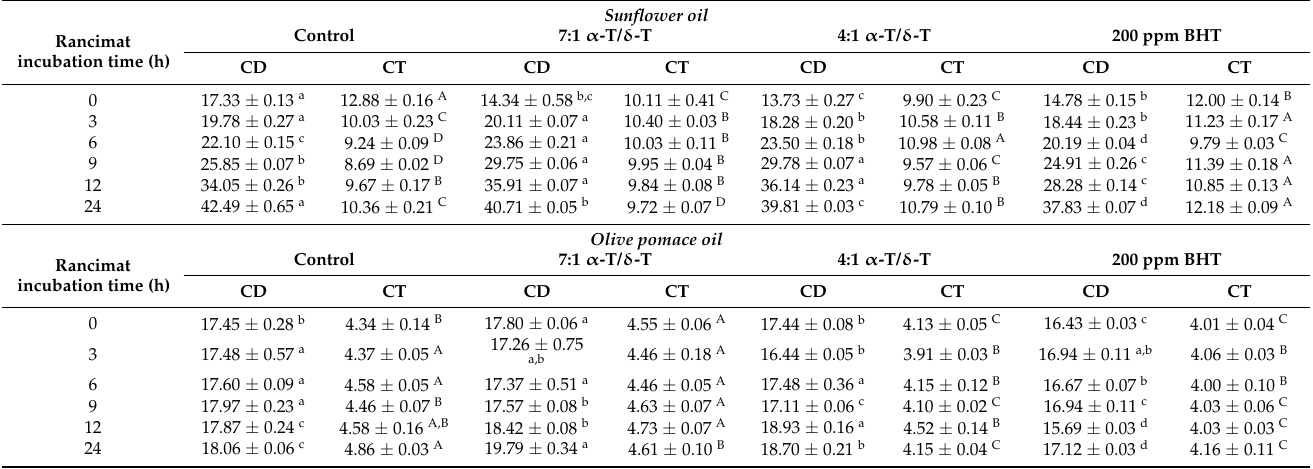
Table 8. Conjugated dienes (CD) and trienes (CT) values (mmol/Kg oil ± SD) in sunflower oil and olive pomace oil samples. Inside rows with a specific superscript letter (e.g., a–d for CD values and A–D for CT values) indicate a significant ( p < 0.05) difference for each Rancimat incubation time. Sunflower